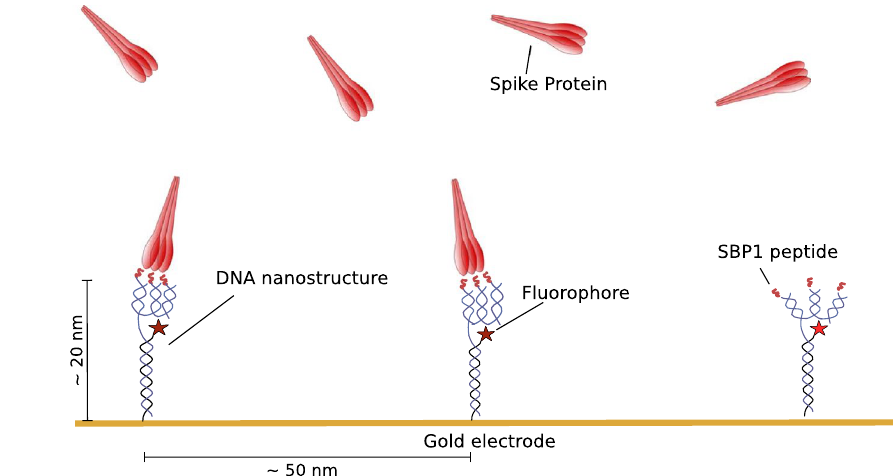
Figure 1. Schematic overview of the experimental setup. Oligovalent DNA structures are immobilized on a gold sensor surface and the binding of spike protein to the oligovalently presented SBP1 peptide is observed. A binding event leads to a reduction of detected fluorescent light intensity. The picture is not drawn to